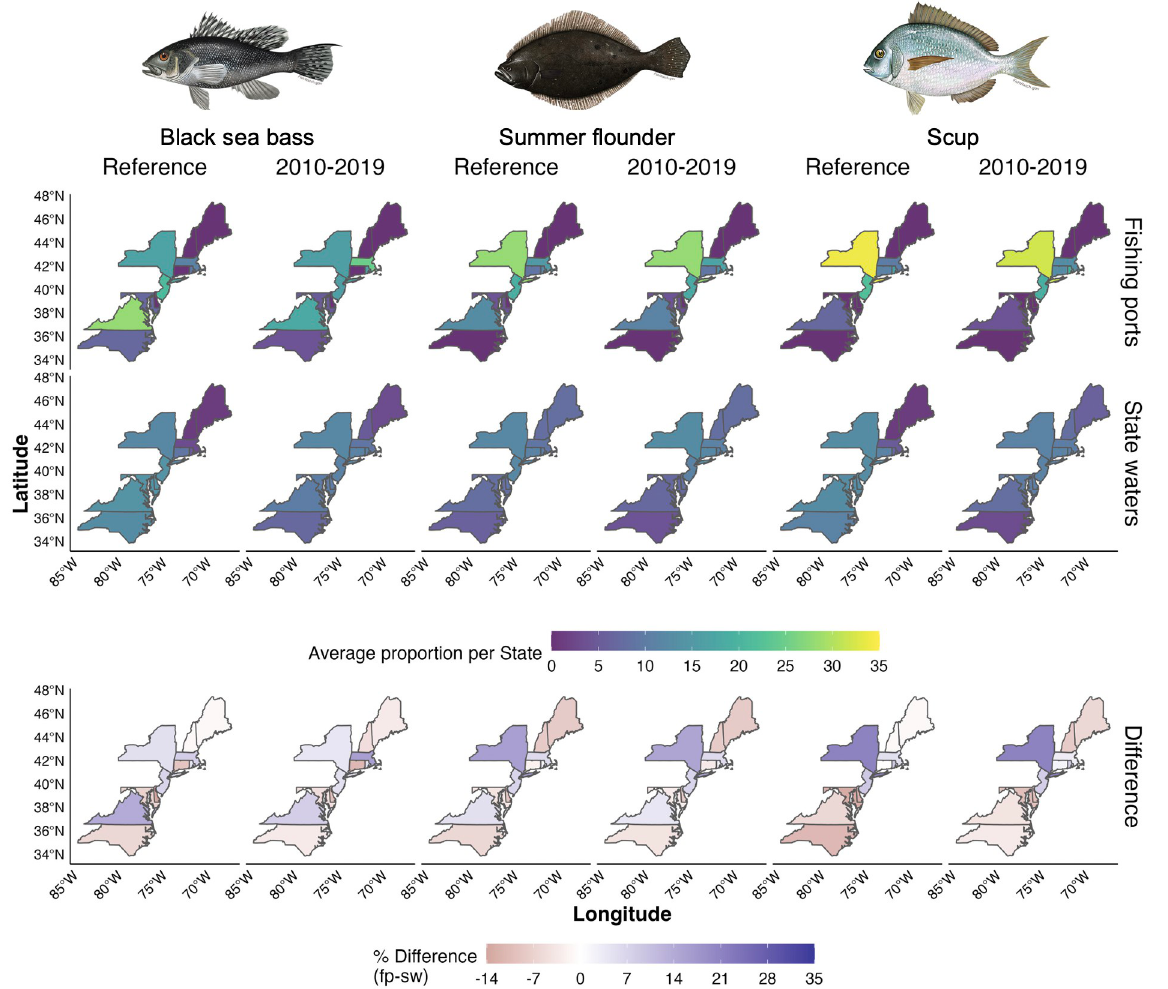
Fig 4. Proportion of trawl survey data as Catch per Unit of Effort (CPUE) for each state and species by spatial approach. Top and middle rows represent the fishing port and state waters approach, respectively. Bottom row is the difference between both approaches ( Δα values in percentage units. Fish images from MAFMC